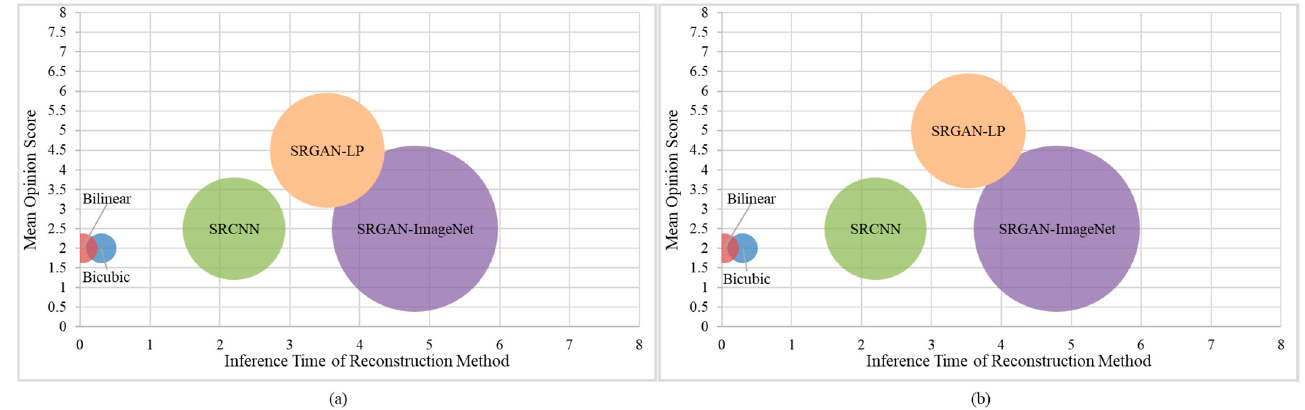
Figure 4 . ( a ) Represents inference time of each reconstruction method on x -axis and mean opinion